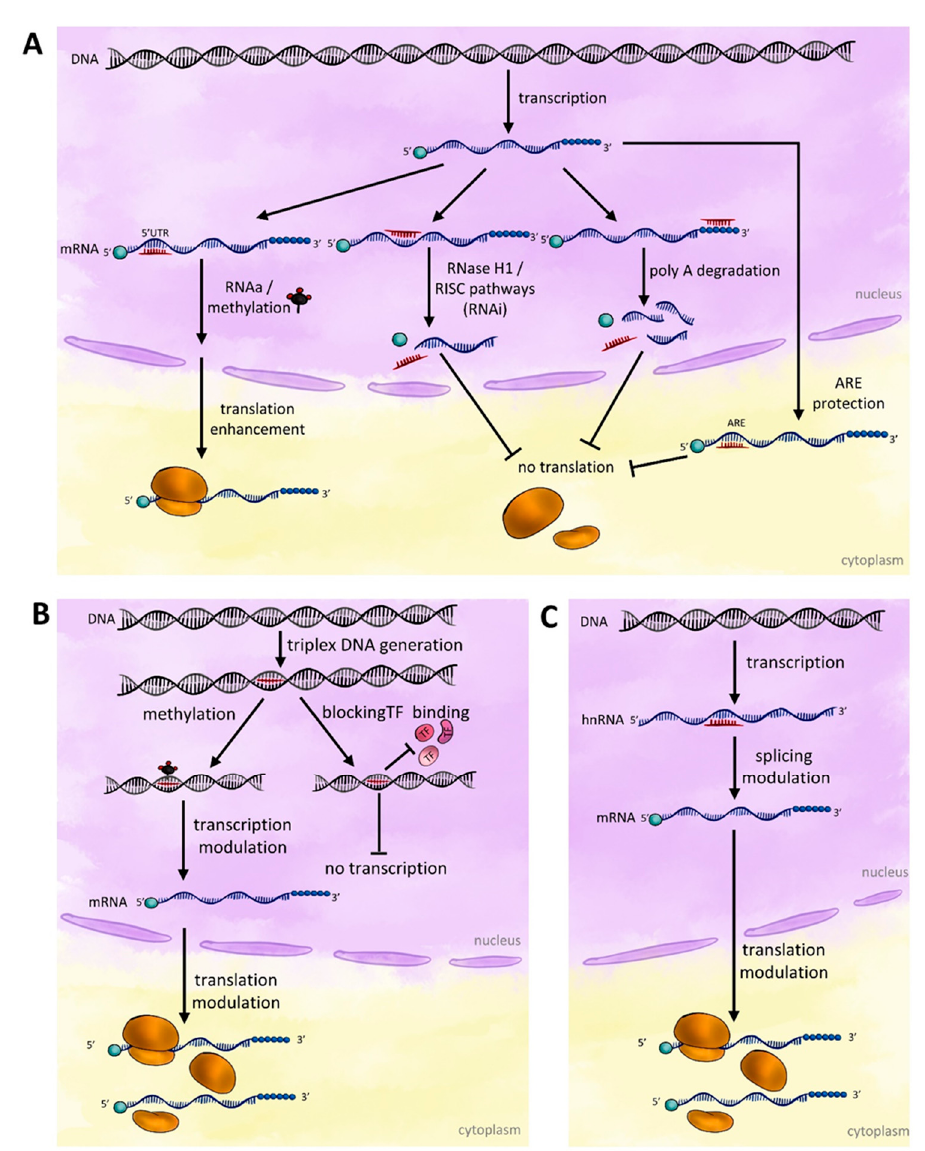
Figure 1. Possible mechanisms of action of oligos in the plant cell depending on the site of binding: ( A ) interaction at the level of genomic DNA, ( B ) at the level of transcript maturation (hnRNA), ( C ) interaction with the transcript (mRNA). Please refer to the main text for further details.